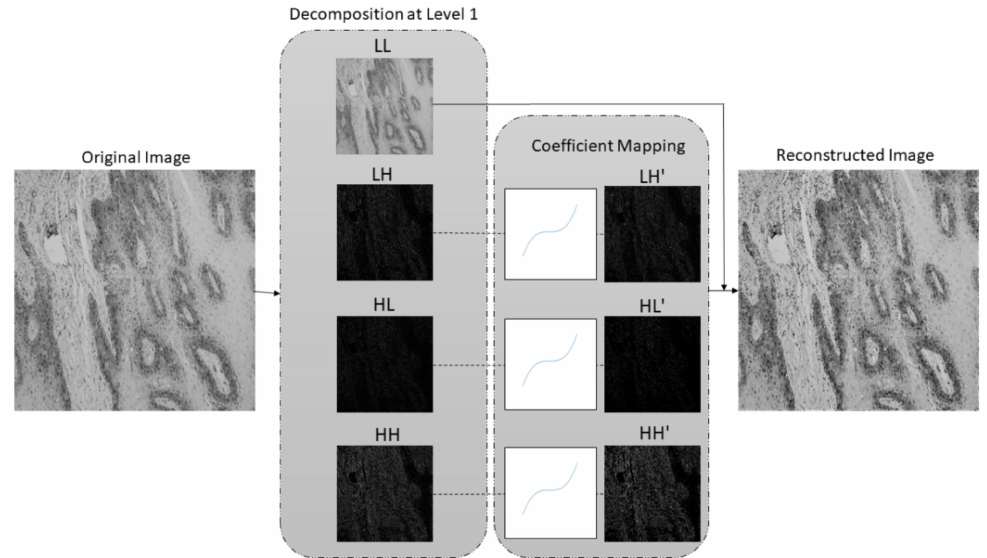
Figure 8. SWT decomposition at level 1 using Haar wavelet along with coefficient mapping, and SWT